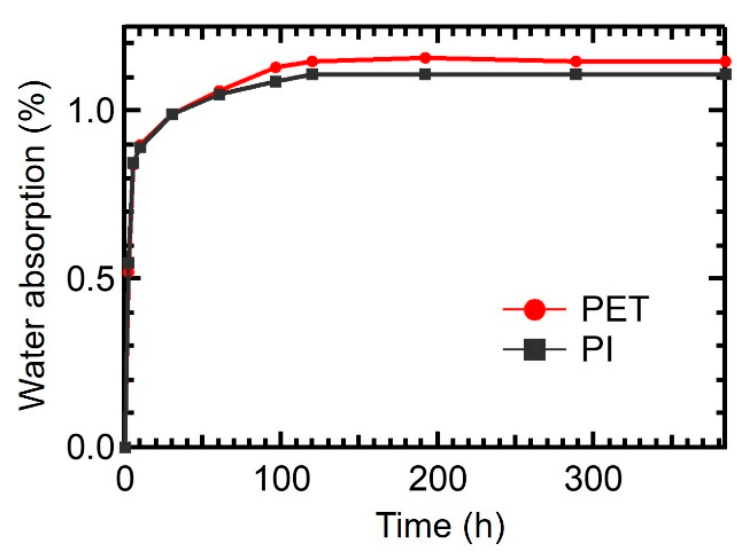
Figure 8. Water absorption curves of PET and PI films. Table 3. Kinetic parameters of the water adsorption on PET and PI films.